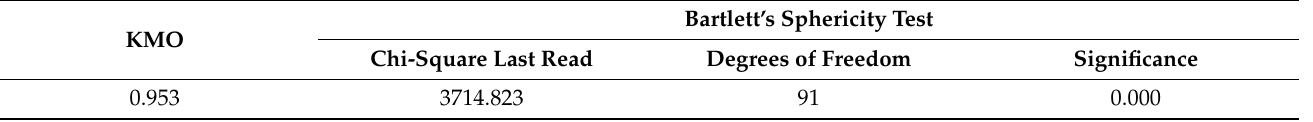
Table 5. The result of validity